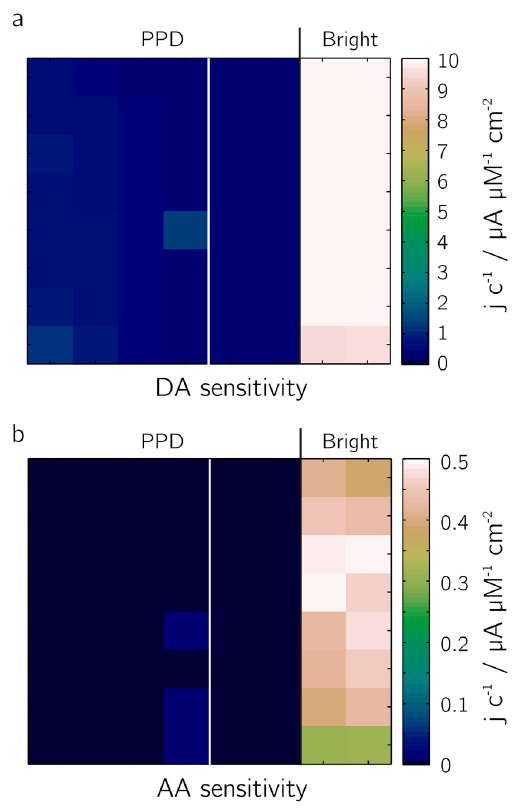
Figure 8. Non-conducting polymer poly(phenylenediamine (PPD). Sensitivity values (in current density per concentration) obtained from measurements of two blocks of 20-µm-diameter electrodes: the left block was completely covered with PPD; half of the right block was covered with PPD and half was left with bright Pt electrodes. Sensitivity was evaluated for ( a ) dopamine and ( b ) ascorbic acid. AA: ascorbic acid; DA: dopamine.